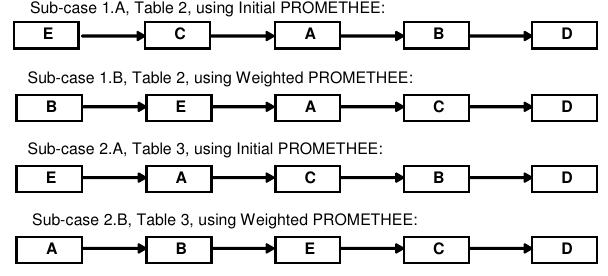
Table 3. Case II, Initial Matrix for La Estrella sub zone, with weights, type of criterion and thresholds, for PROMETHEE. Alternatives